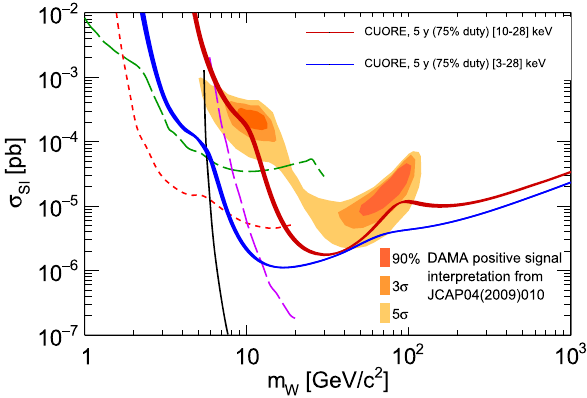
Fig. 6 90% sensitivities on the SI elastic WIMP-nucleon cross section asafunctionofWIMPmassofCUORE,assuming5yearsofdata-taking with 75% of duty cycle and 10keV threshold (red), as well as 3keV threshold (blue). Uncertainty on the energy scale dominated by the nuclear quenching factor is taken into account. DAMA/LIBRA positive signal reported in [31] is shown as yellow/dark yellow/orange islands. The results from CRESST-II (dashed green) [32], CDMS Lite (dashed red) [33], XMASS (dashed violet) [34], and LUX (black solid) [35] are also